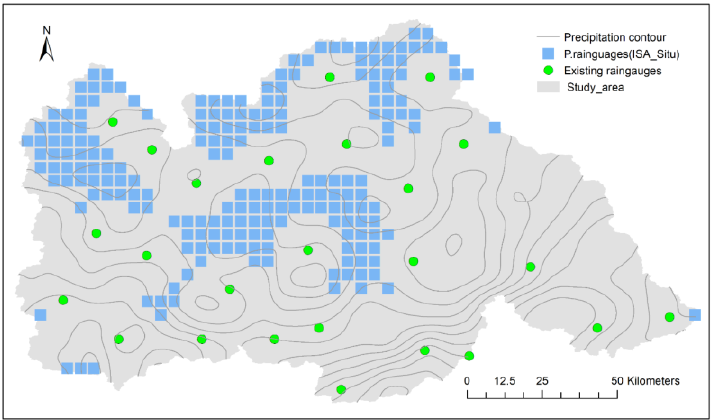
Figure 16. Distribution of the potential positions of the 26th rain gauge using the S-ISA method.